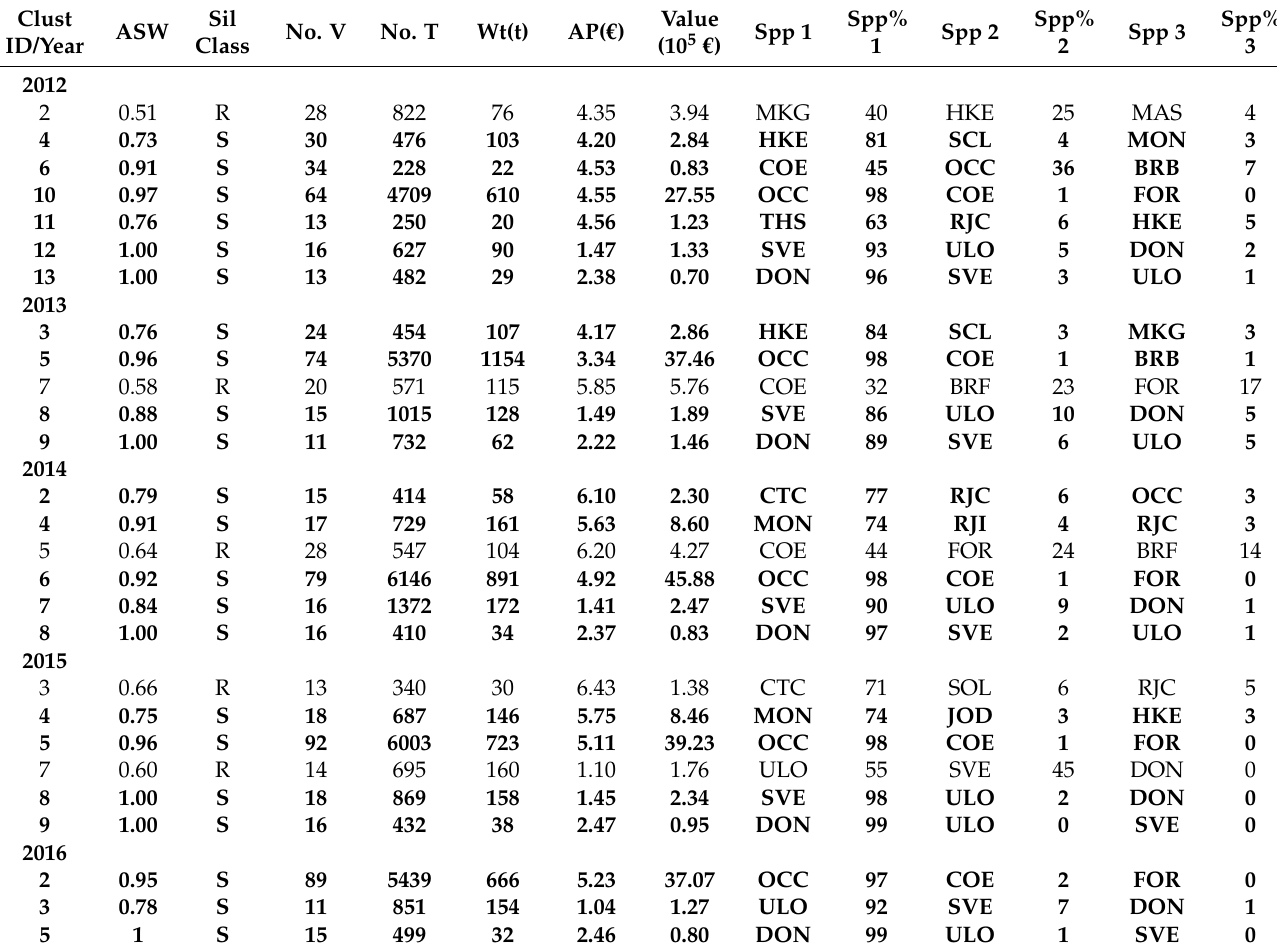
Table 2. Outputs for yearly clusters (Annex Figure S2) with the cluster ID, average silhouette width of the cluster (ASW), the silhouette class (SC; S = strong, in bold; R = reasonable), number of vessels (No. V), number of trips (No. T), total weight in tonnes (in tonnes), average price (AP) in Euros, total value in Euros, the three top species (Spp) and the percentage (Spp%) that each species represented within the species (in quantity). (FAO Codes of primary species for reasonable and strongly structured clusters (Annex Table S2): BRB = Black seabream; COE = Conger eel; CTC = Cuttlefish; DON = Donax